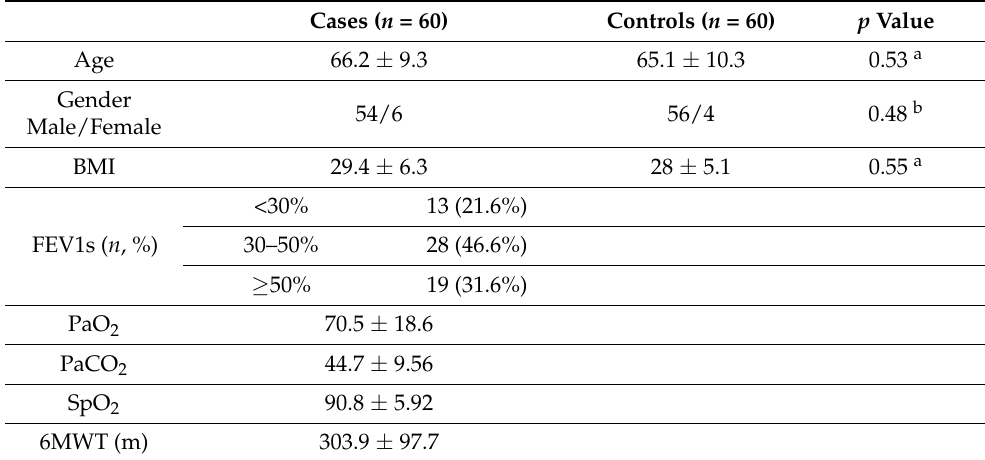
Table 1. Demographic characteristics and clinical parameters of participants.